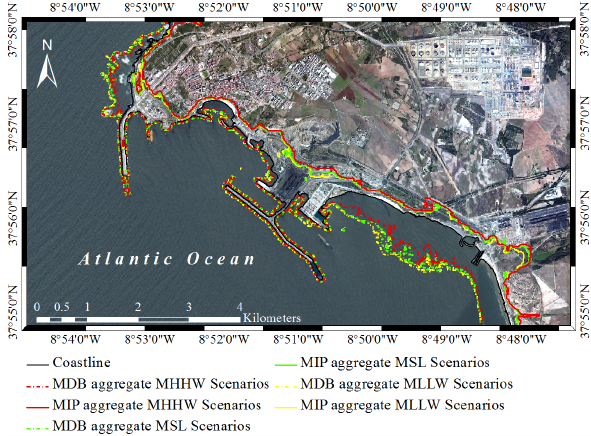
Figure 7. MDB and MIP limits for the stages MLLW, MSL, and MHHW of the